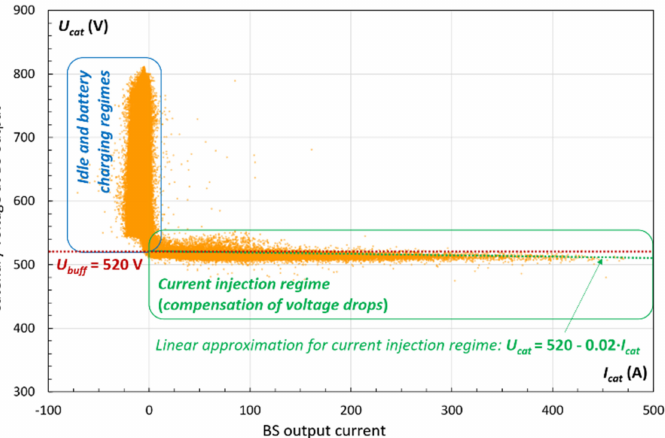
Figure 3. Buffer station output voltage vs. buffer station output current—recorded on Thursday, week